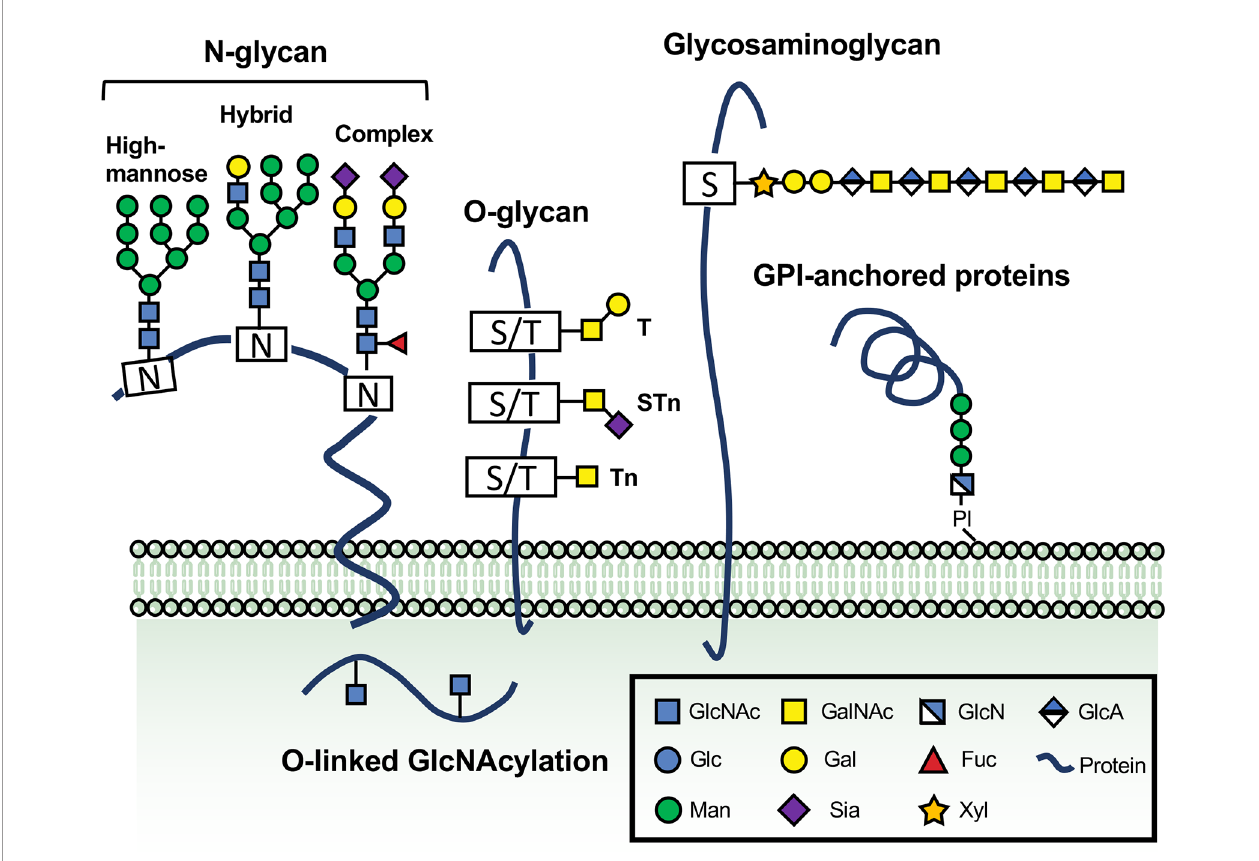
FIGURE 1 | The vital roles of glycosylation in physiological and pathological processes. Glycans are formed by the attachment of saccharides or sugar chains to proteins and lipids. A great number of naturally occurring glycans are abundant on the surface and cytoplasm of the cells. The main classes of glycoproteins consist of at least fi ve major types, N-glycans, O-glycans, glycosaminoglycan, GPI-anchored proteins, and O-linked GlcNAcylation. N-glycans are generally considered the critical type of the cell surface glycoproteins because of their direct implications in cellular recognition and signaling transduction. They are covalently linked to asparagine (Asn) residues of polypeptide backbone via nitrogen linkages. N-glycans are divided into high-mannose, hybrid and complex types. Another common type of glycans involved in regulating immune responses and controlling cell metabolism is O-glycan, which can be further extended into long chains. A single O-GlcNAc addition to Ser/Thr residues catalyzed through OGT or EGF domain-speci fi c O-linked GlcNAc transferase (EOGT) is mostly found on extracellular or intracellular compartments. Glycosylphosphatidylinositol (GPI) anchor is a molecule composed of a glycan linked to a polypeptide chain. Glycosaminoglycans (GAGs) represent a signi fi cant type of glycoproteins that are de fi ned by the presence of long disaccharide repeats and further classi fi ed according to the composition of their repeating units. The glycosaminoglycans and GPI anchor are also